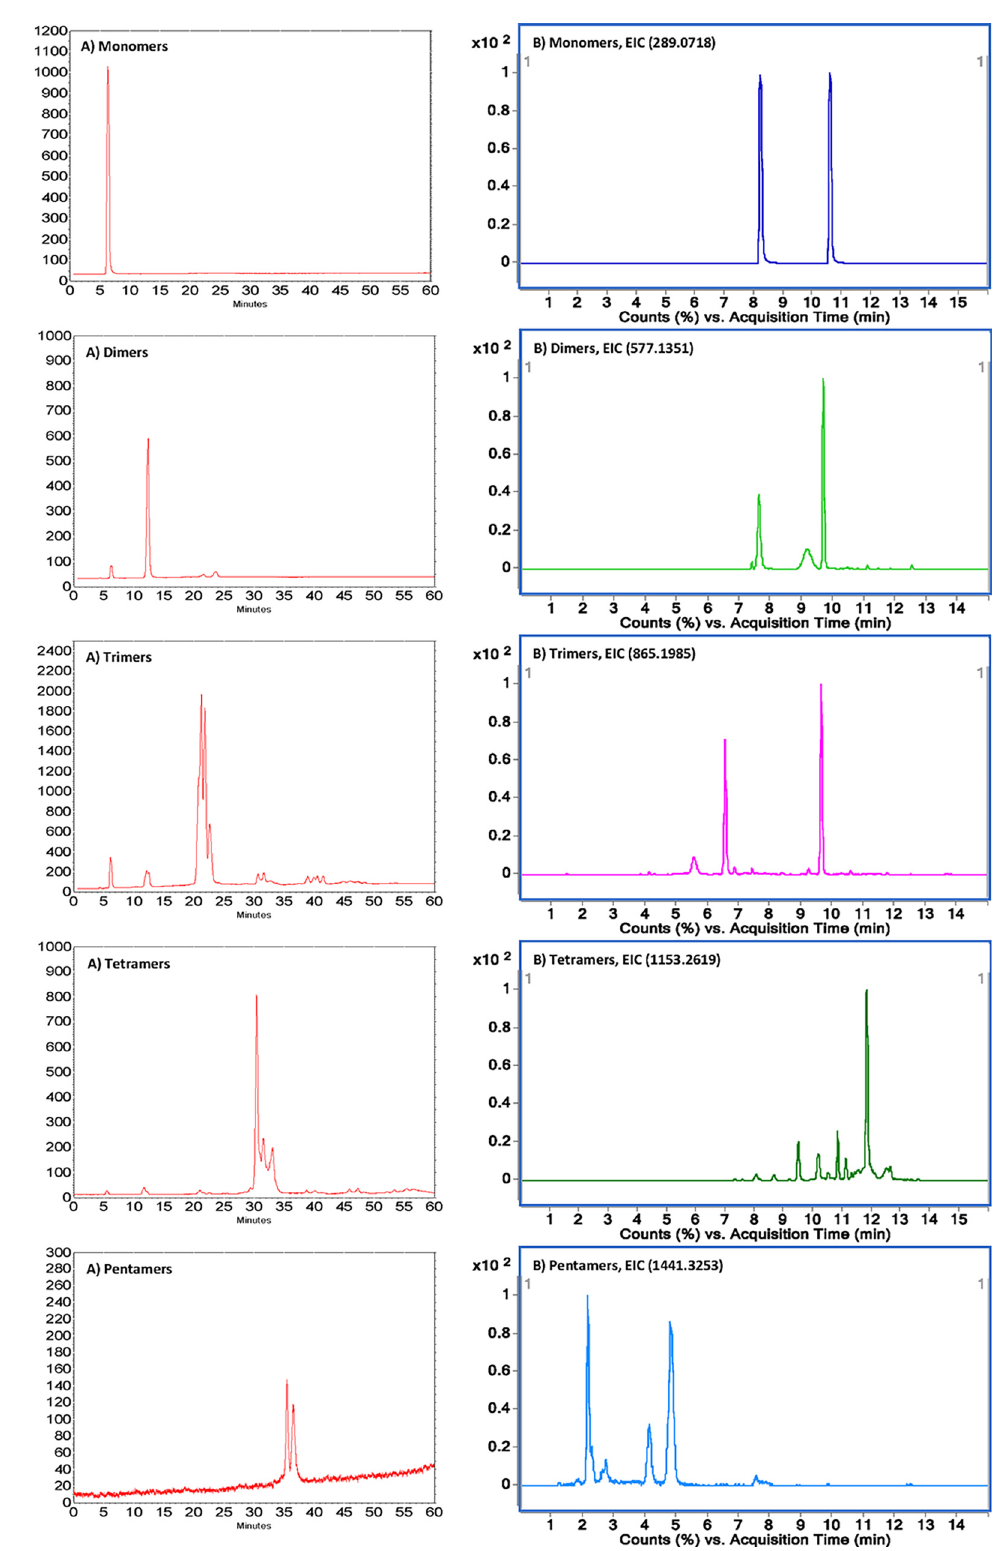
Fig 4. Two complementary and orthogonal HPLC approaches to identify the five purified PAs: A). Normal phase HPLC-FLD chromatograms to separate PAs according to their DP; B). Reverse phase UHPLC-Q-TOF extracted ion chromatograms to separate isomeric PAs at the same